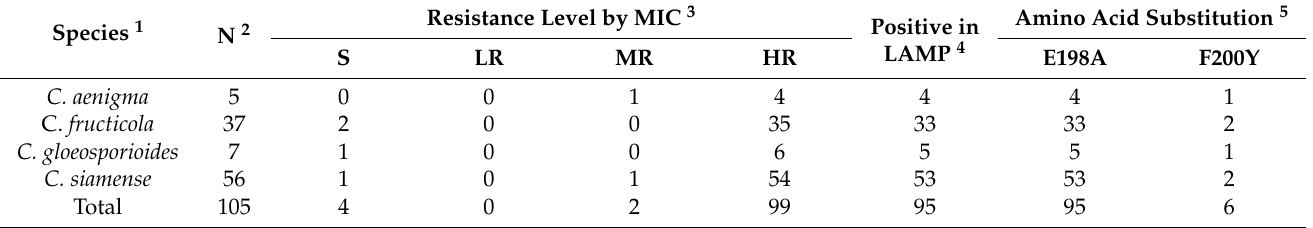
Table 3. Thiophanate-methyl resistance phenotypes and genotypes of Colletotrichum spp.